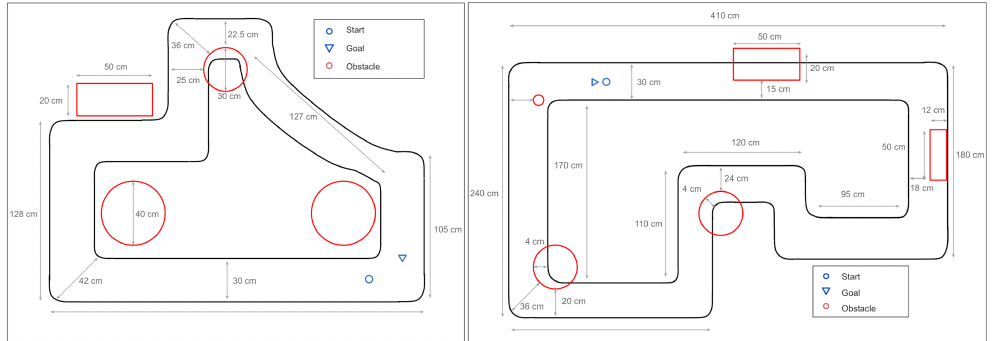
Figure 11. Real-scale track maps for physical self-driving